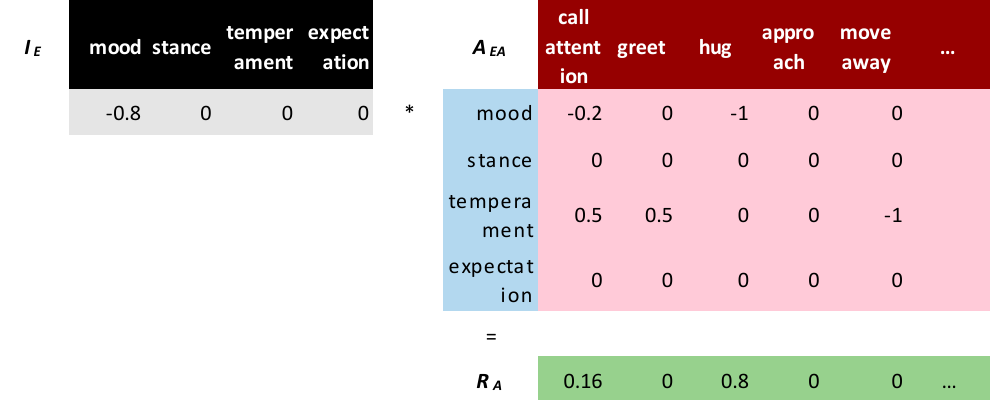
Figure 7. Matrix multiplication resulting in a vector containing an action.